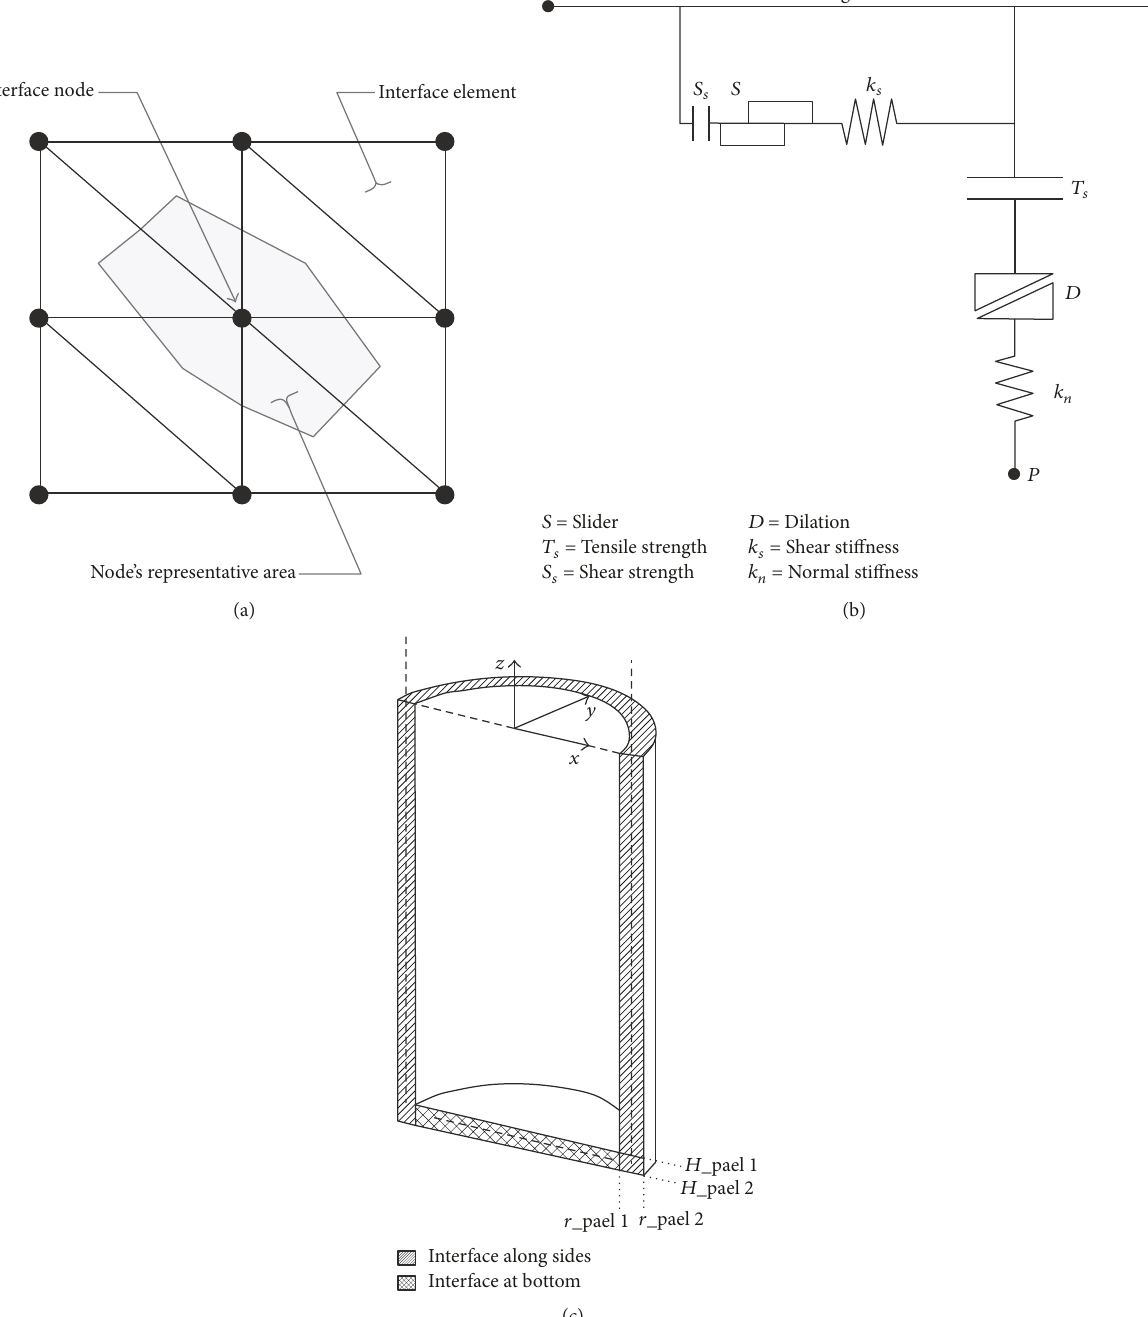
Figure 4: (a) Interface elements; (b) constitutive parameters in the interface; (c) bottom and side interface elements